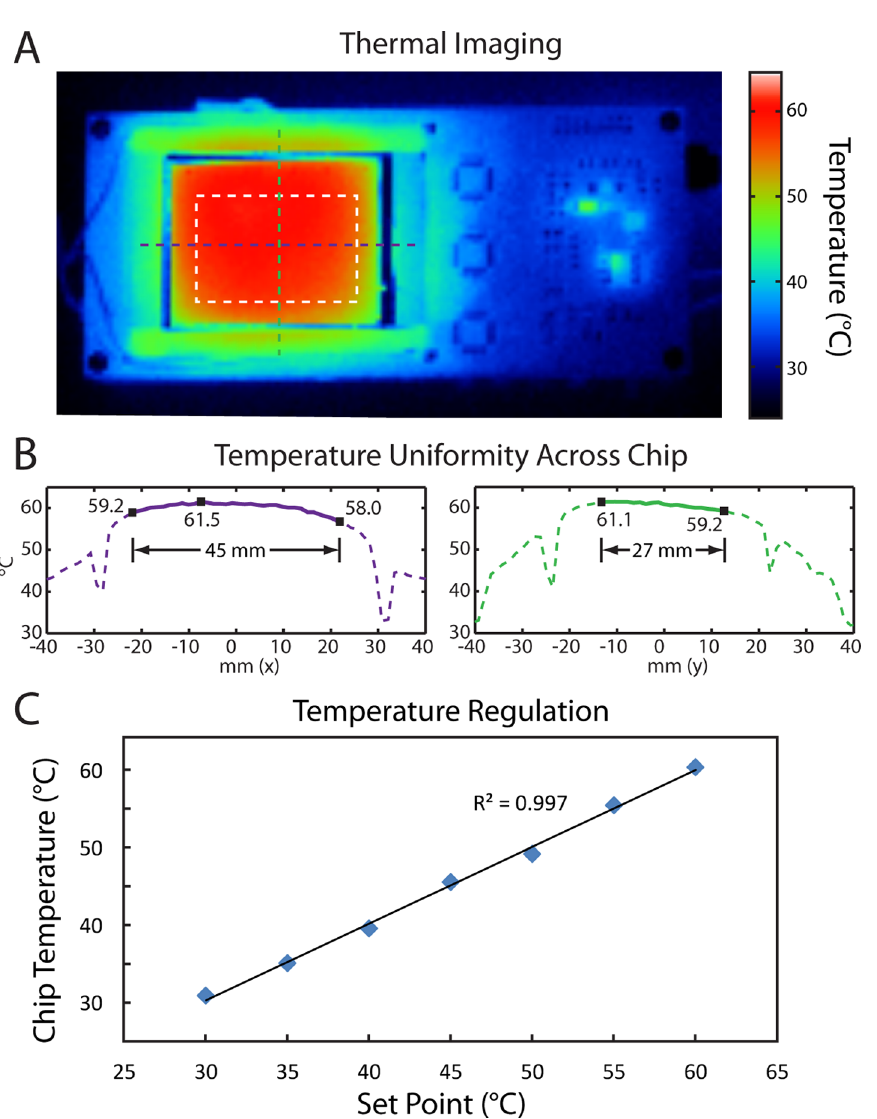
Figure 4. Heater uniformity and stability. (A) Infrared thermal image of the m BAR (case removed) at 60 u C. The white box indicates the extent of the 6 6 10 reaction chamber array. (B) Linescans through this region indicate a temperature uniformity of 6 1.25 u C. (C) Chip temperature, as measured with a thermocouple directly embedded in the PDMS, versus m BAR temperature set point.